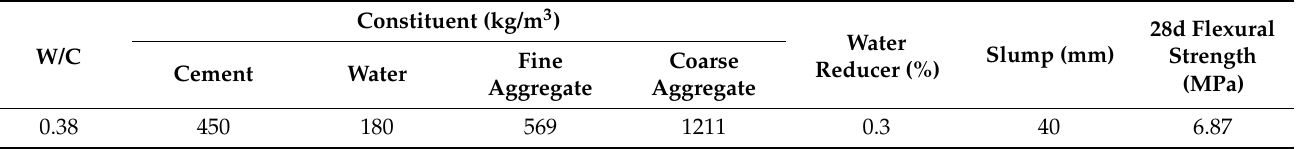
Table 2. Proportion and flexural strength of the control